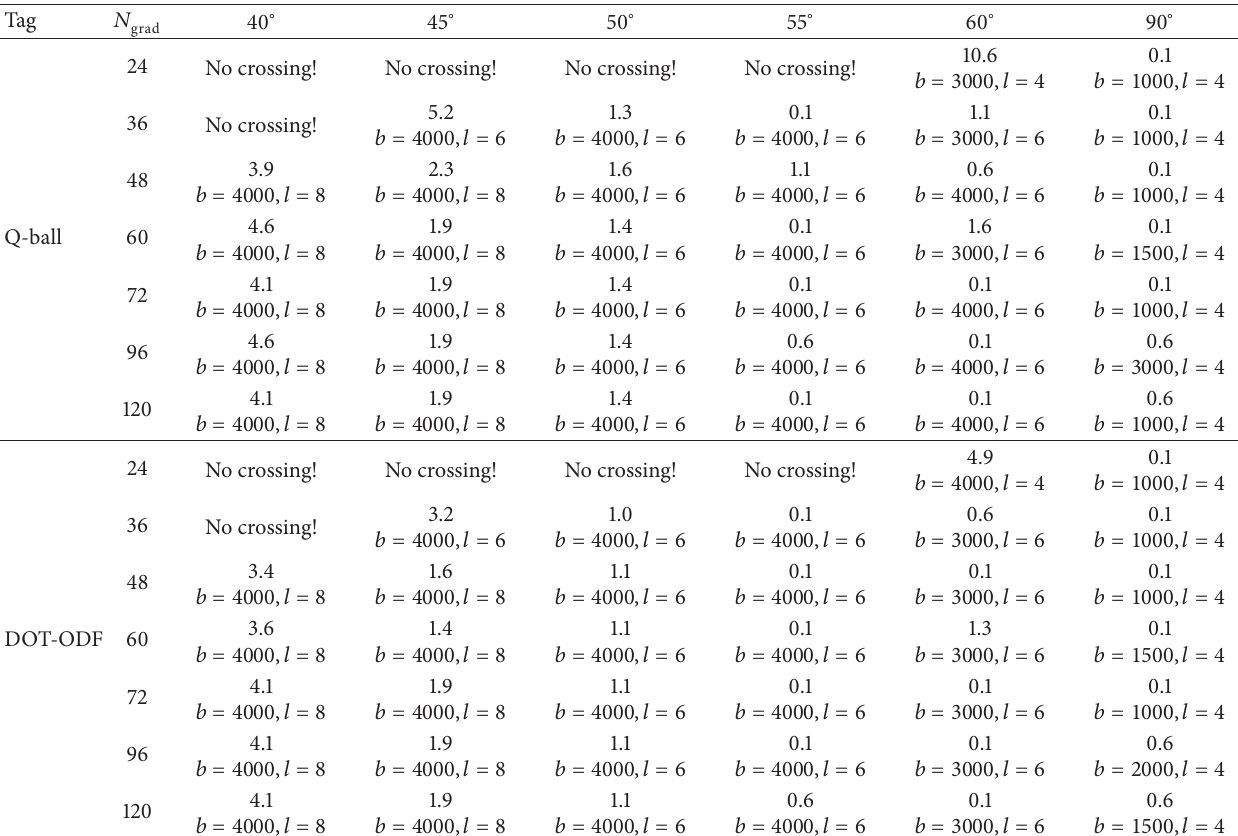
Table 4: S¨oderman’s model without added noise, with tolerance: 0.5 ∘ . The table presents the optimal combination of 𝑏 -value (s/mm 2 ) and 𝑙 -order together with the detected angular error ( ∘ ) for each combination of simulated angle and number of gradients.